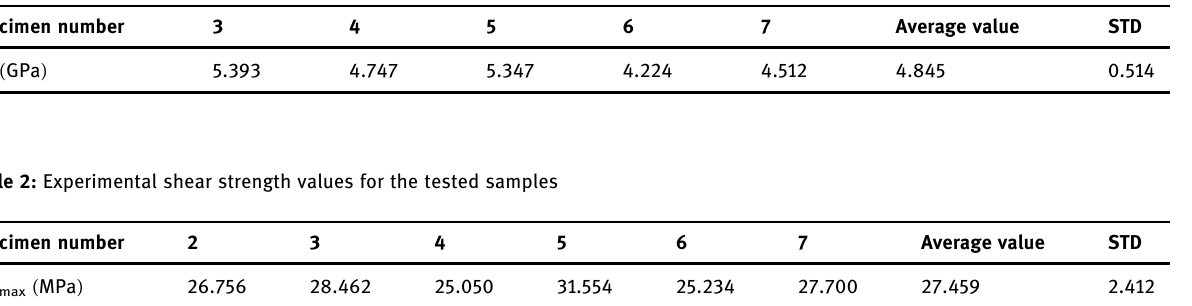
Table 1: Experimental measured values of the shear modulus G 12